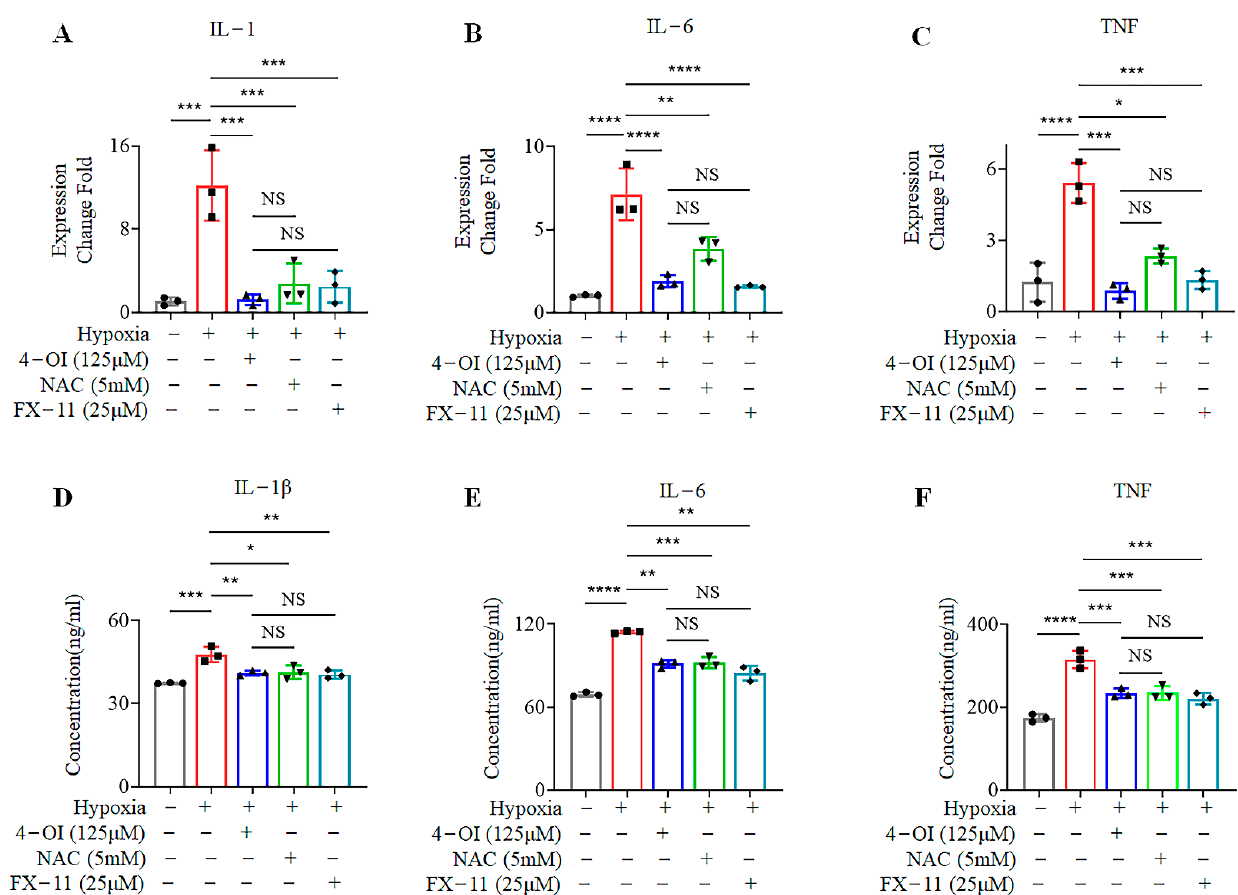
Figure 5. Treatment with 4-OI reduces the secretion of inflammatory factors in MIN6 cells under oxidative stress: ( A – C ) The mRNA levels of IL-1 , IL-6 , and TNF- α , respectively, in MIN6 cells after the indicated treatments, quantified by q-PCR. ( D – F ) The released levels of IL-1 β , IL-6, and TNF- α , respectively, from MIN6 cells under hypoxia was assessed by ELISA. Error bars represent the mean ± SD. One-way ANOVA was performed with * p < 0.05, ** p < 0.005, *** p < 0.0005, **** p < 0.00005, NS: non-significant.